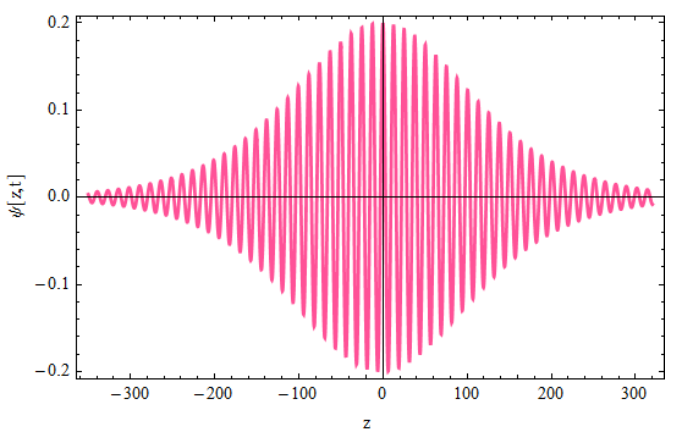
Figure 8. Change of real part of solution (20) with z , t for c = 0.5, v = 0.7, β 1 = 0.05, β 2 = 1, β 3 = 0, β 4 = 0.